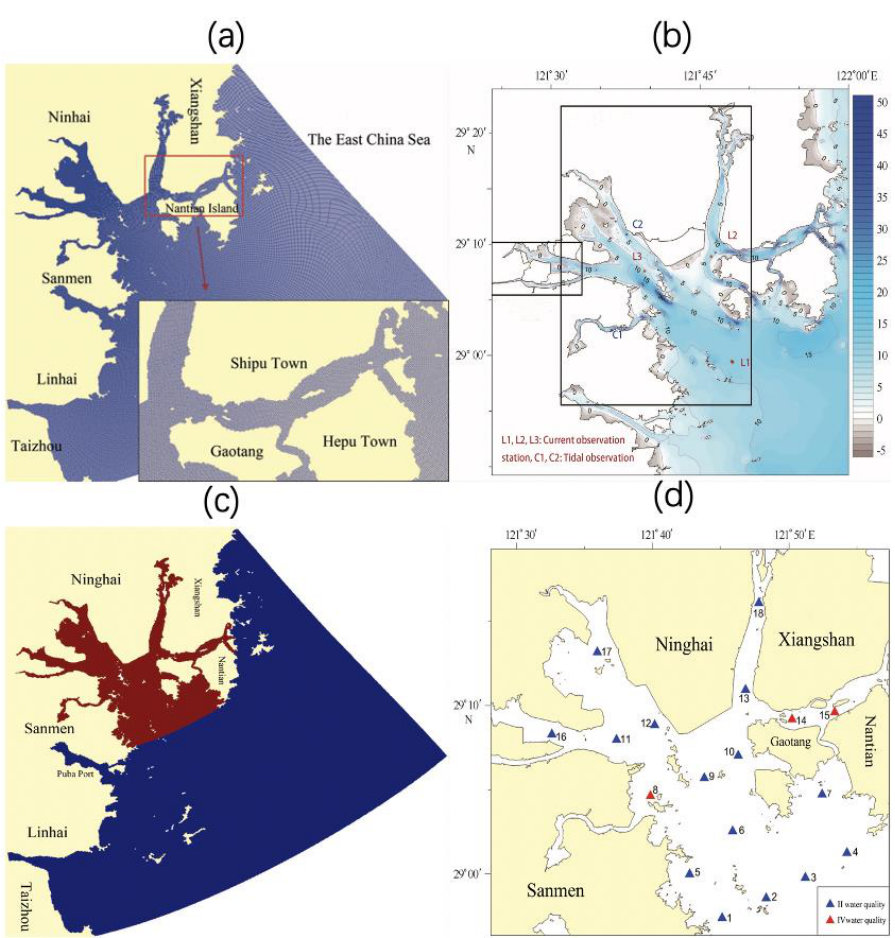
Figure 1. ( a ) Model domain for Sanmen Bay, ( b ) Location of observation stations, ( c ) Initial conditions of water exchange model (The concentration distribution in Sanmen Bay is set as 1 unit, red in the figure, the inflow outside the bay and at the boundary is set as 0, dark blue in the figure), ( d ) Water quality control stations in Sanmen Bay.